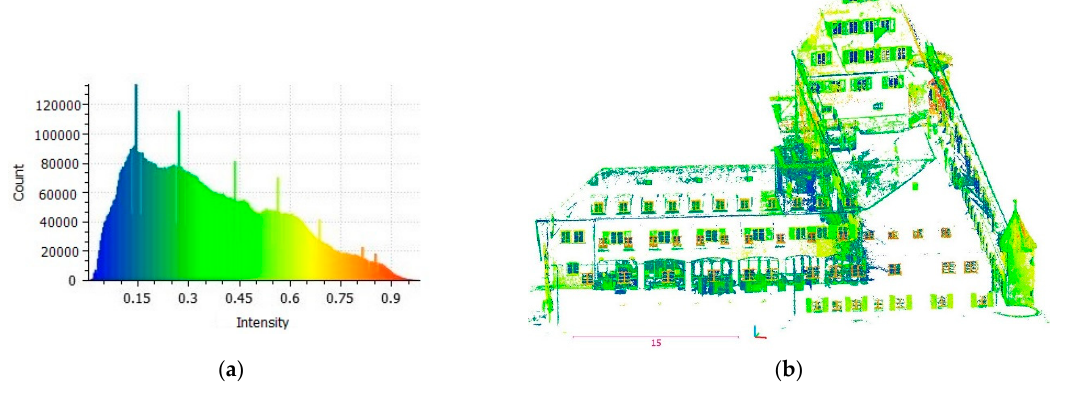
Figure 15. Applying intensity thresholding. ( a ) Intensity histogram and ( b ) the highlighted corresponding intensity on the point cloud.